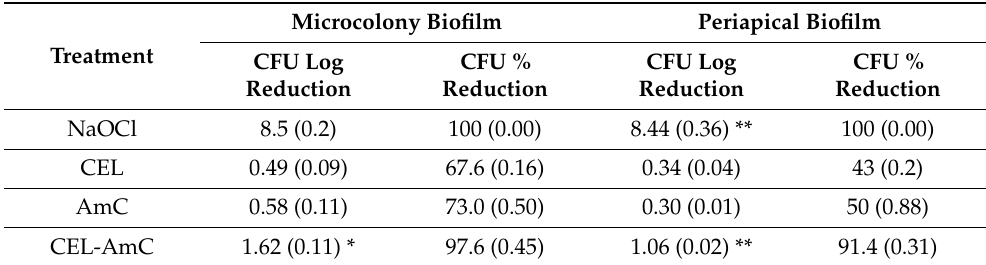
Table 2. Evaluation of antibiofilm treatment on microcolony and periapical